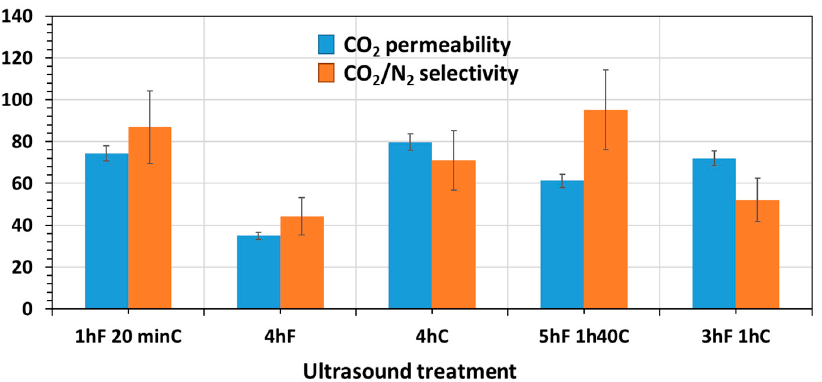
Figure 11. CO 2 permeability (Blue) and CO 2 /N 2 selectivity (Orange) of MMMs according to the ultrasound treatment. (The large error in the selectivity is due to the large uncertainty in N2 permeability).